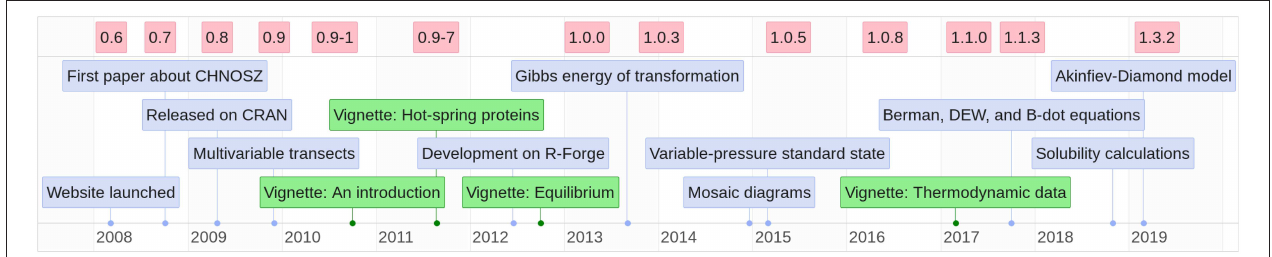
FIGURE 1 | Timeline of the development of CHNOSZ since 2008. Red boxes indicate major release versions, blue boxes indicate new features or other updates, and green boxes indicate the addition of vignettes to the package documentation.